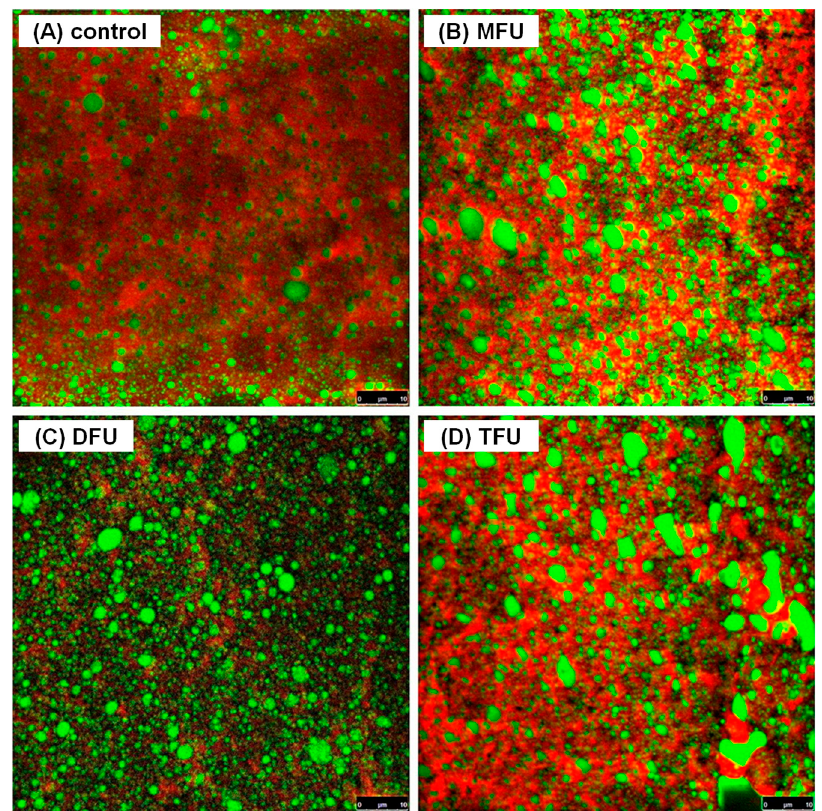
Figure 4. Confocal laser scanning micrographs of WPEG with whey protein pretreated by different ultrasound (( A )—control, ( B )—MFU (300 W), ( C )—DFU (240 W), ( D )—TFU (180 W)).